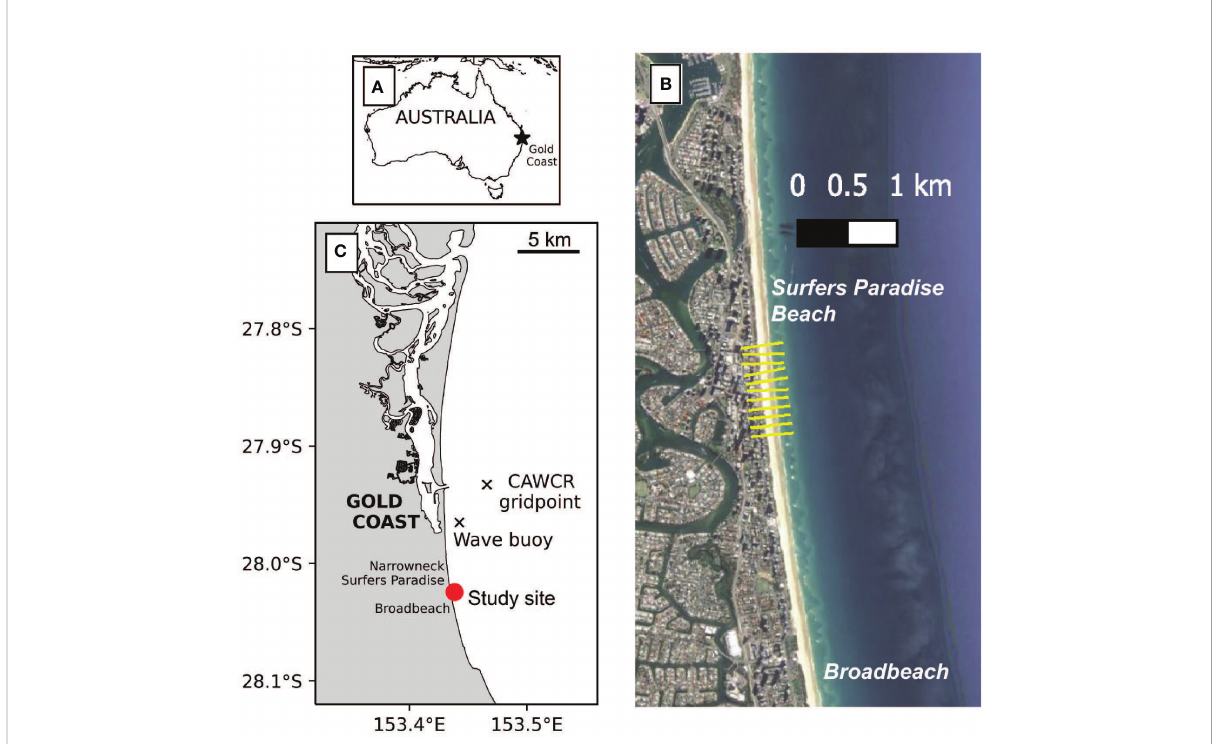
FIGURE 1 Study site and data. (A) Location of the Gold Coast on the east coast of Australia. (B) Satellite image (source: Google Earth) of the study site and the location of ten shore-normal transects (yellow lines) used for extraction of satellite-derived shoreline time series. (C) Map of the Gold Coast location showing speci fi c location of the study site (red point). Black crosses indicate the location of the waverider buoy and the CAWCR gridpoint used to fi ll gaps in wave